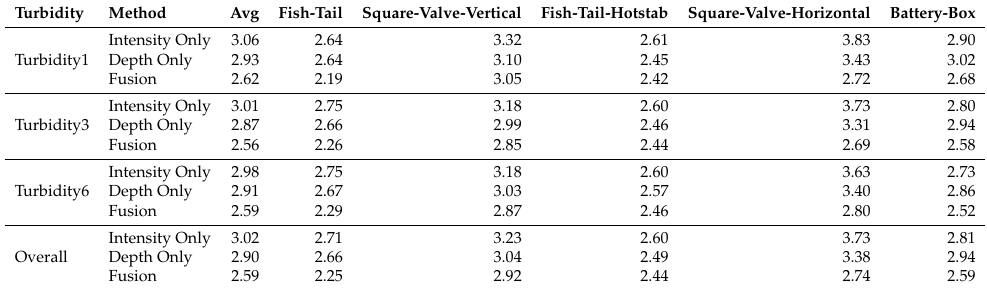
Table 4. Per class rotation error(RRE) in degree ( ◦ ) for the test dataset. The results are averaged over all